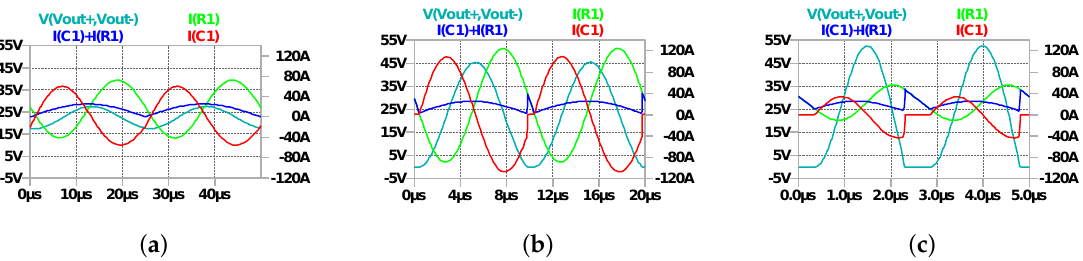
Figure 6. Rectifier output voltage V ( vout + ,vout − ) , current flowing in C 0 I ( C 1 ) , battery current I ( R 1 ) , and rectifier output current I ( C 1 ) + I ( R 1 ) in Test 1. Continuous-mode operation for f SS = 20kHz ( a ). Discontinuous-mode for f SS = 50kHz ( b ) and f SS = 200kHz ( c